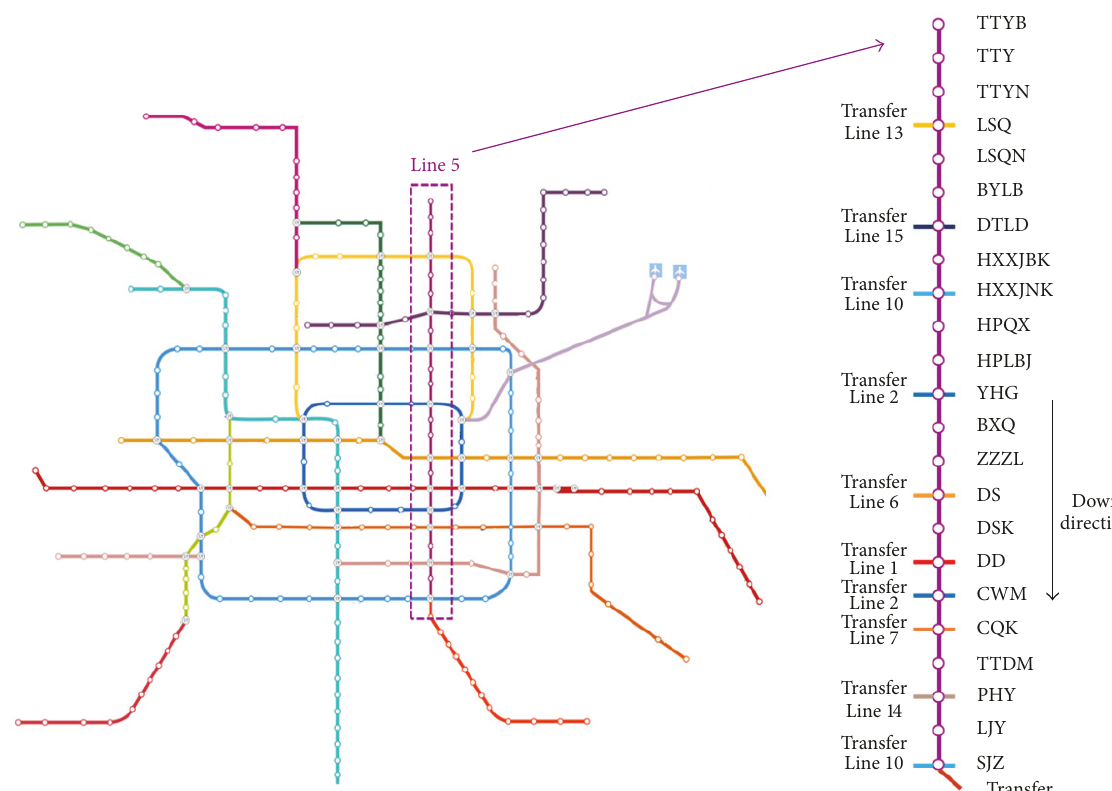
Figure 10: Beijing Metro network and Line